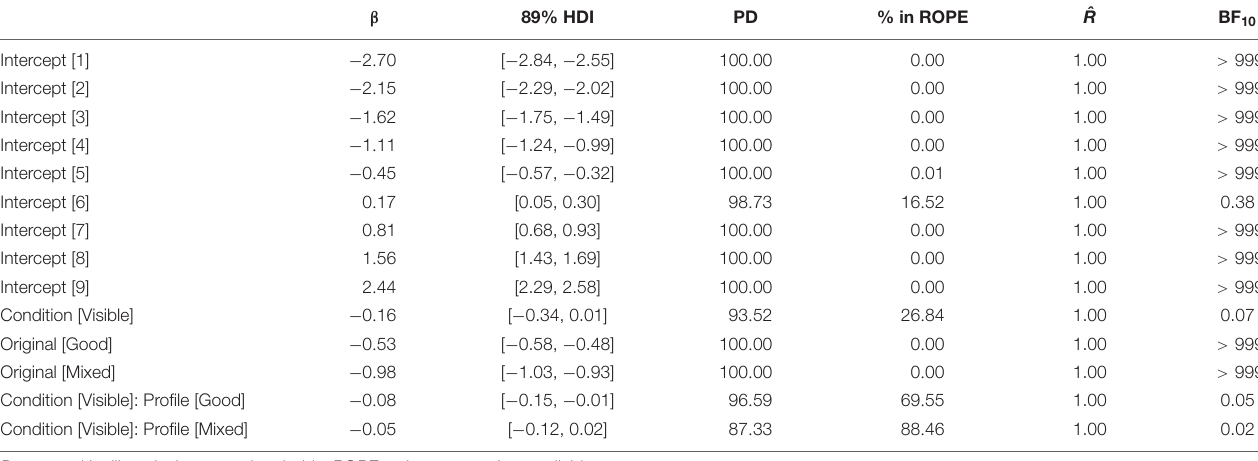
TABLE 5 | Summary of the model fitted to the sociability ratings, considering the experimental condition (Visible or Reveal) and Profile type (Good, Mixed, and Bad).